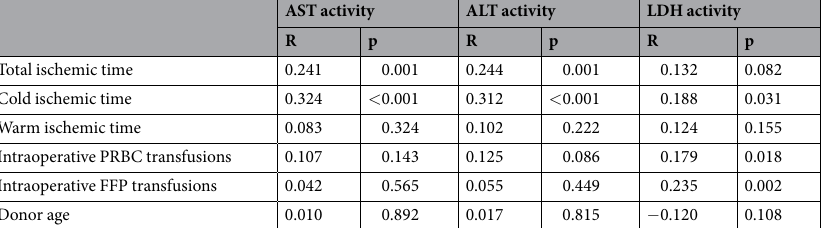
Table 2. Analyses of correlations between selected factors and activity of aspartate transaminase (AST), alaninę transaminase (ALT), and lactate dehydrogenase (LDH) at 2 hours after reperfusion in liver transplantation for hepatocellular carcinoma. Correlations were assessed with Spearman correlation coefficients. AST – aspartate transaminase; ALT – alanine transaminase; LDH – lactate dehydrogenase; PRBC – packed red blood cells; FFP – fresh frozen